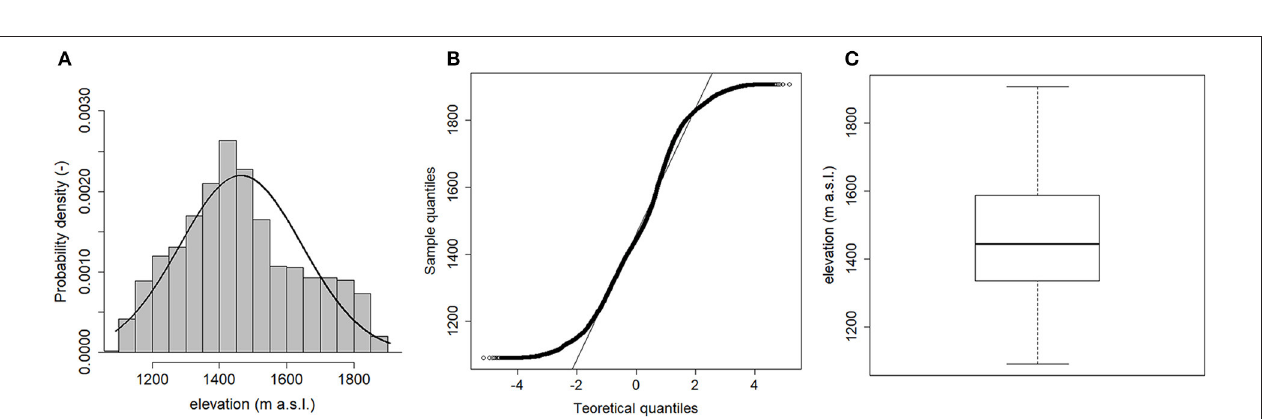
FIGURE 2 | (A) Histogram of the errors dataset. Superimposed, the normal distribution with mean and standard deviation estimated from the original errors dataset. (B) Normal Q-Q plot of the errors dataset. (C) Histogram of the errors dataset without outliers. Superimposed, the normal distribution with mean and standard deviation estimated from the thresholded errors dataset. (D) Normal Q-Q plot of the errors dataset without outliers. DZ denotes the vertical error.